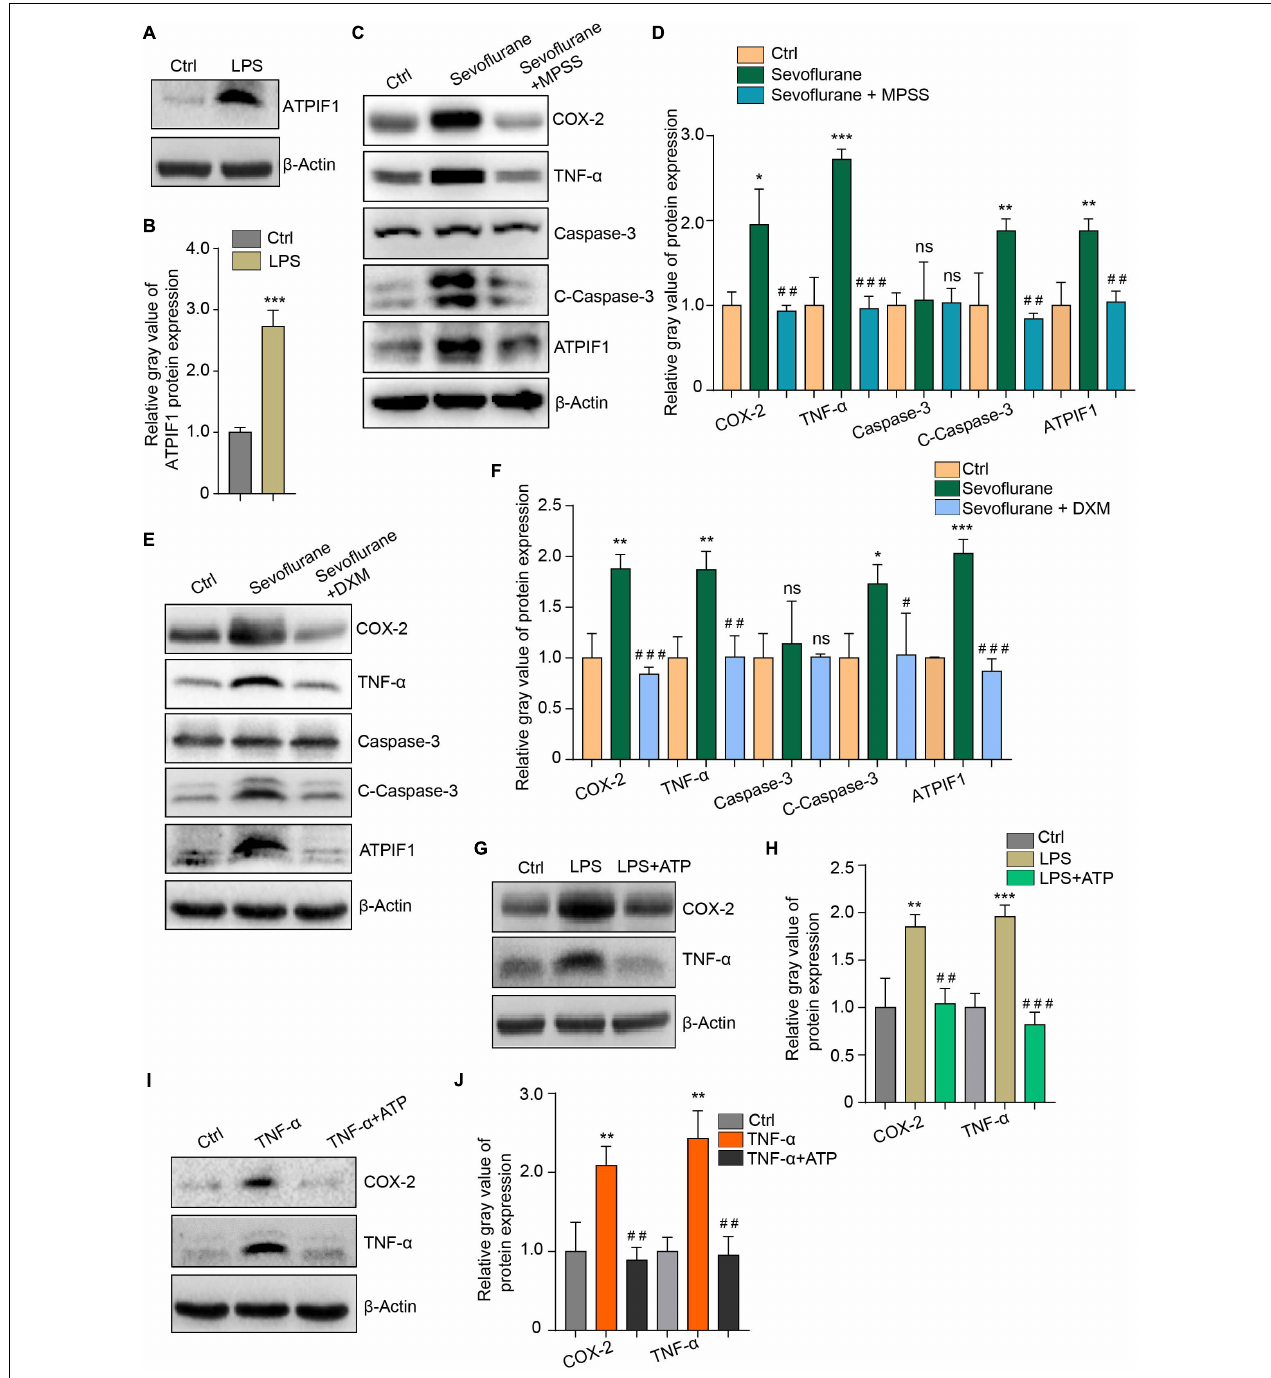
FIGURE 4 | Inflammation regulates ATPIF1 expression and is attenuated by additional ATP supplementation in microglia. (A) LPS treatment upregulates ATPIF1 expression in microglia. (B) Statistics of the relative gray value indicating the ATPIF1 protein expression in panel (A) . (C) Methylprednisolone sodium succinate (MPSS) attenuated the COX-2 and TNF- α upregulation and promotion of caspase-3 activation caused by sevoflurane. (D) Statistics of the relative gray value indicating the protein expression in panel (C) . (E) Dexamethasone (DXM) also attenuated the COX-2 and TNF- α upregulation and promotion of caspase-3 activation caused by sevoflurane. (F) Statistics of the relative gray value indicating the protein expression in panel (E) . (G) ATP (50 µ g/ml) ameliorated LPS induced inflammation in mouse primary microglia. (H) Statistics of the relative gray value indicating the protein expression in panel (G) . (I) ATP (50 µ g/ml) ameliorated TNF- α -induced inflammation in mouse primary microglia. (J) Statistics of the relative gray value indicating the protein expression in panel (I) . Ctrl means control. β -Actin served as a loading control. Student’s t -test was used to determine differences in panel (B) . One-way ANOVA with repeated measurement were used to determine differences in panels (D,F,H,J) . The data shown are the means ± SD, n = 3. * or # means p < 0.05, ** or ## means p < 0.01, *** or ### means p < 0.001. ns means no significant difference.